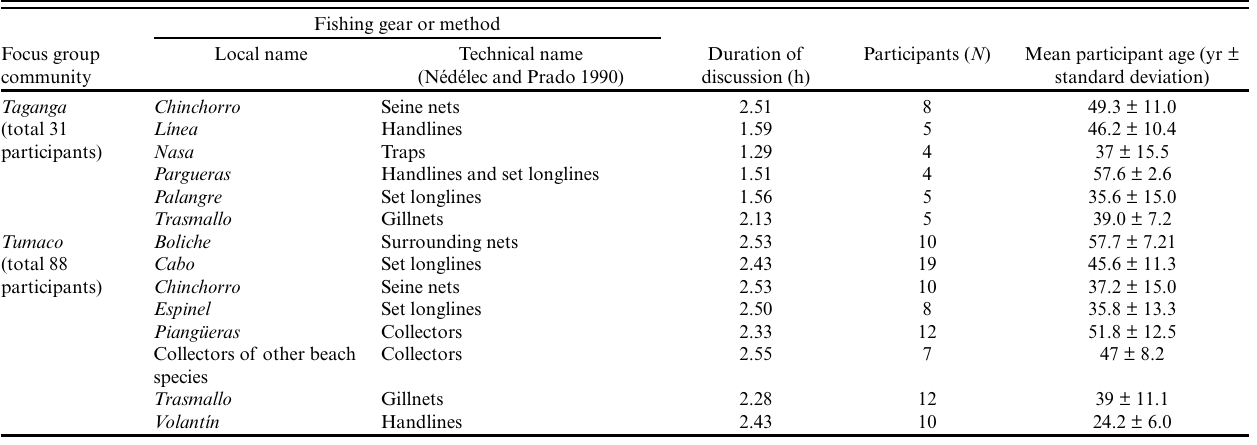
Table 3. Characteristics of focus groups and participants in Taganga and